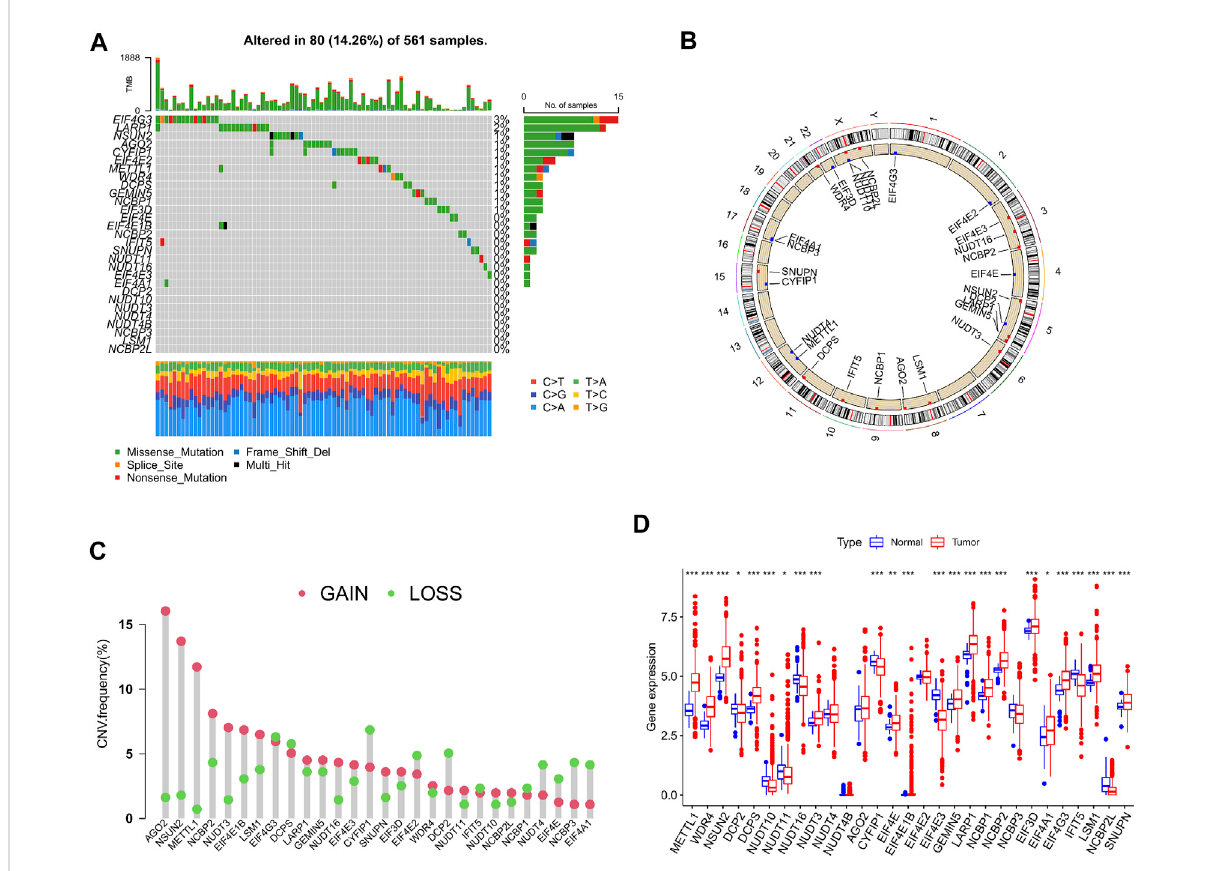
FIGURE 2 Genetic alterations of m7G-associated genes in lung adenocarcinoma (LUAD). (A) Mutation frequency of 29 m7G-associated genes in LUAD patients ( n = 561). (B) Position of copy number variations (CNV) of the 29 m7G-associated genes on 23 chromosomes (red indicates gain of copy number; blue indicates loss of copy number). (C) CNV of the 29 m7G-associated genes (red indicates gain of copy number; green indicates loss of copy number). (D) Expression of the 29 m7G-associated genes in LUAD and normal tissue